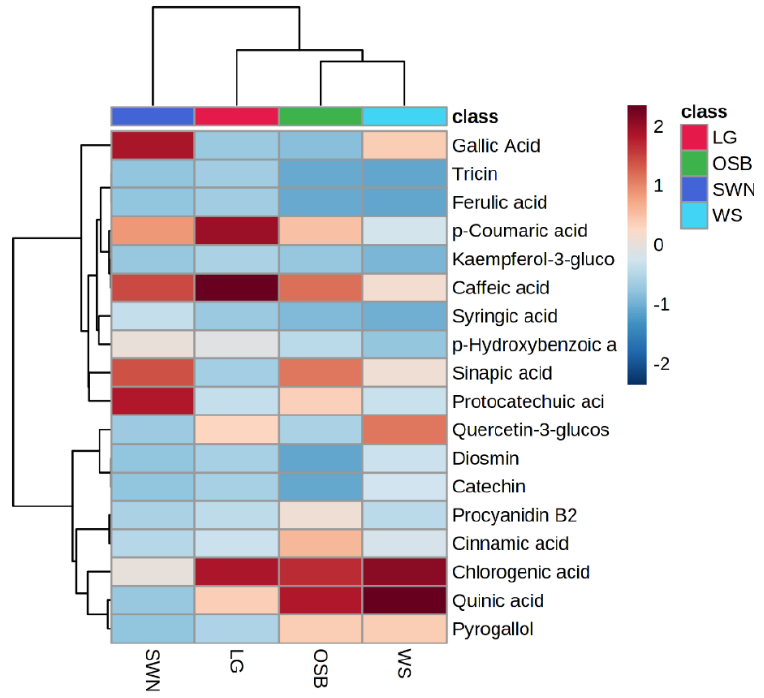
Figure 4. Heatmap hierarchical clustering of quantified phenolic metabolites.